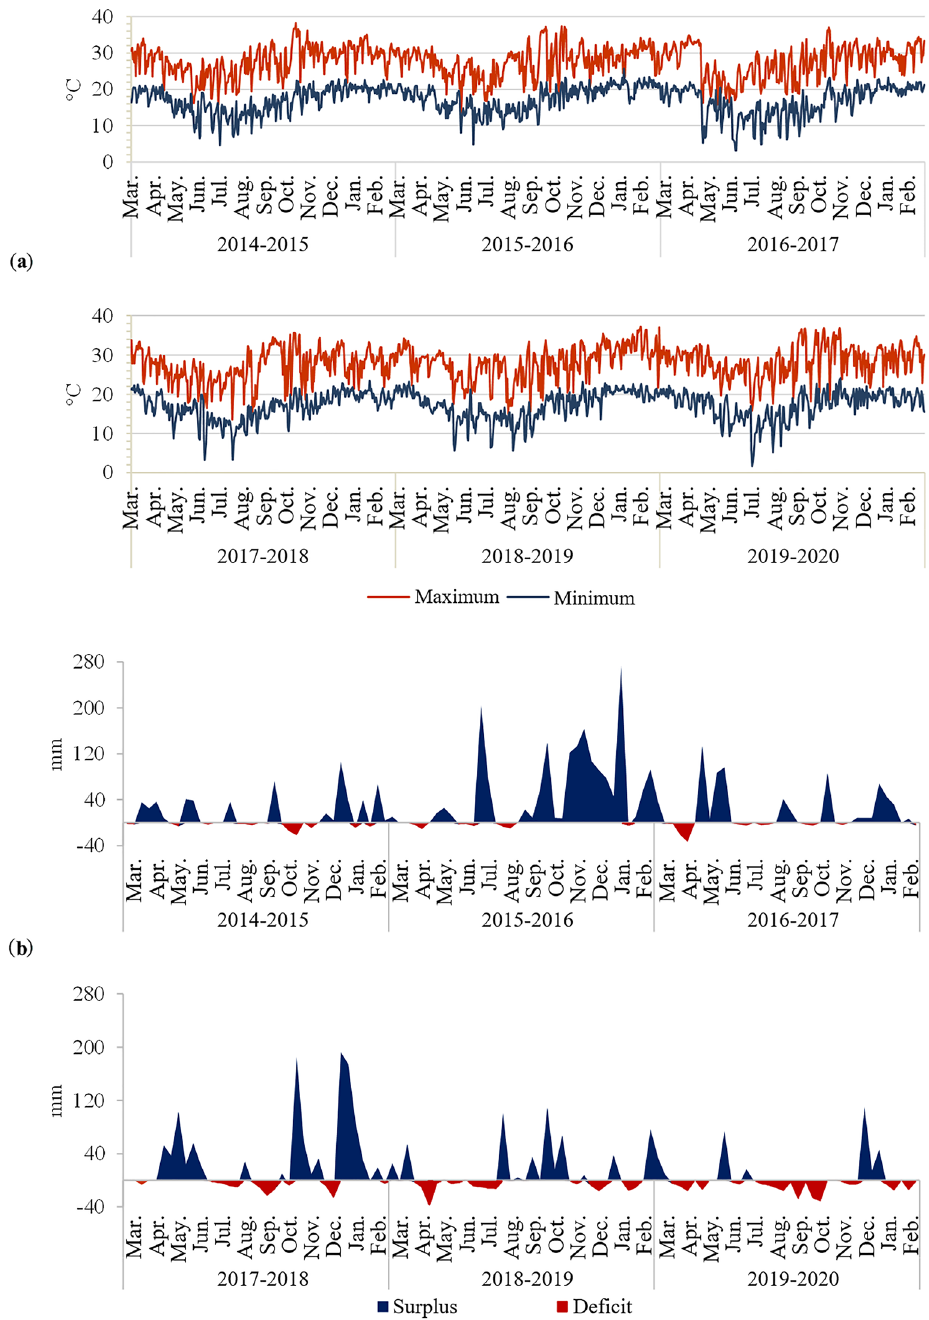
Figure 1. ( a ) Maximum and minimum daily temperatures and ( b ) ten-year water balance (AWC = 80 mm), Londrina, Paraná State, Brazil, between crop years 2014–2015 and 2019–2020. Prepared based on data from the Paraná Environmental Technology and Monitoring System (Sistema de Tecnologia e Monitoramento do